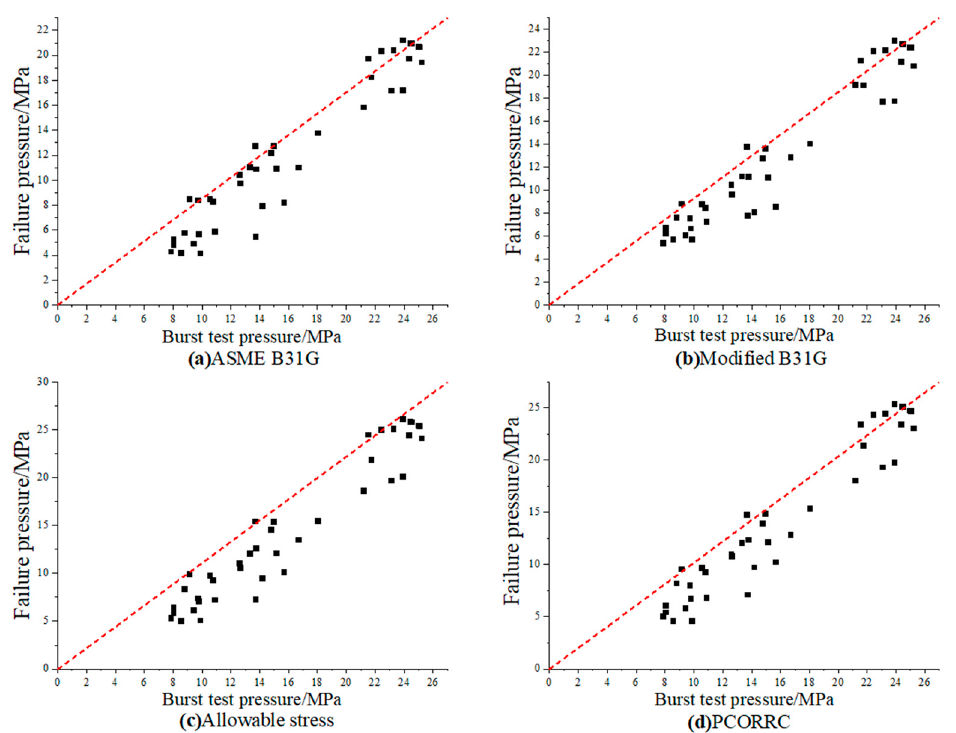
Figure 7. Comparison of burst pressure and predicted failure pressure of low-strength pipelines calculated by different methods: ( a ) ASME B31G; ( b ) Modified B31G; ( c ) Allowable stress; ( d ) PCORRC.